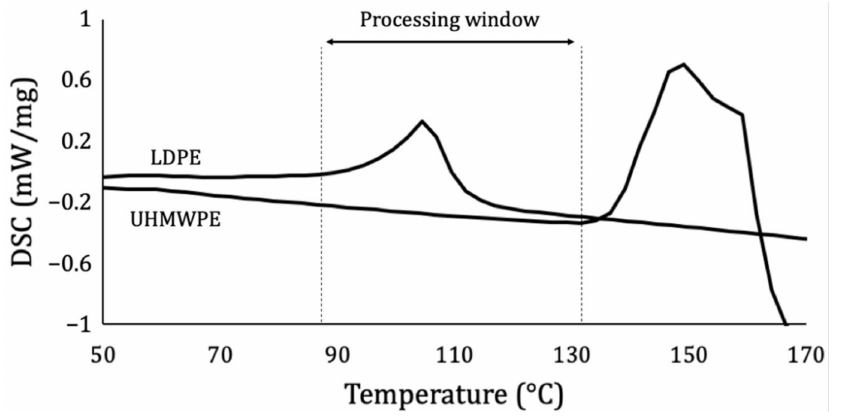
Figure 2. Definition of temperature window for processing through DSC